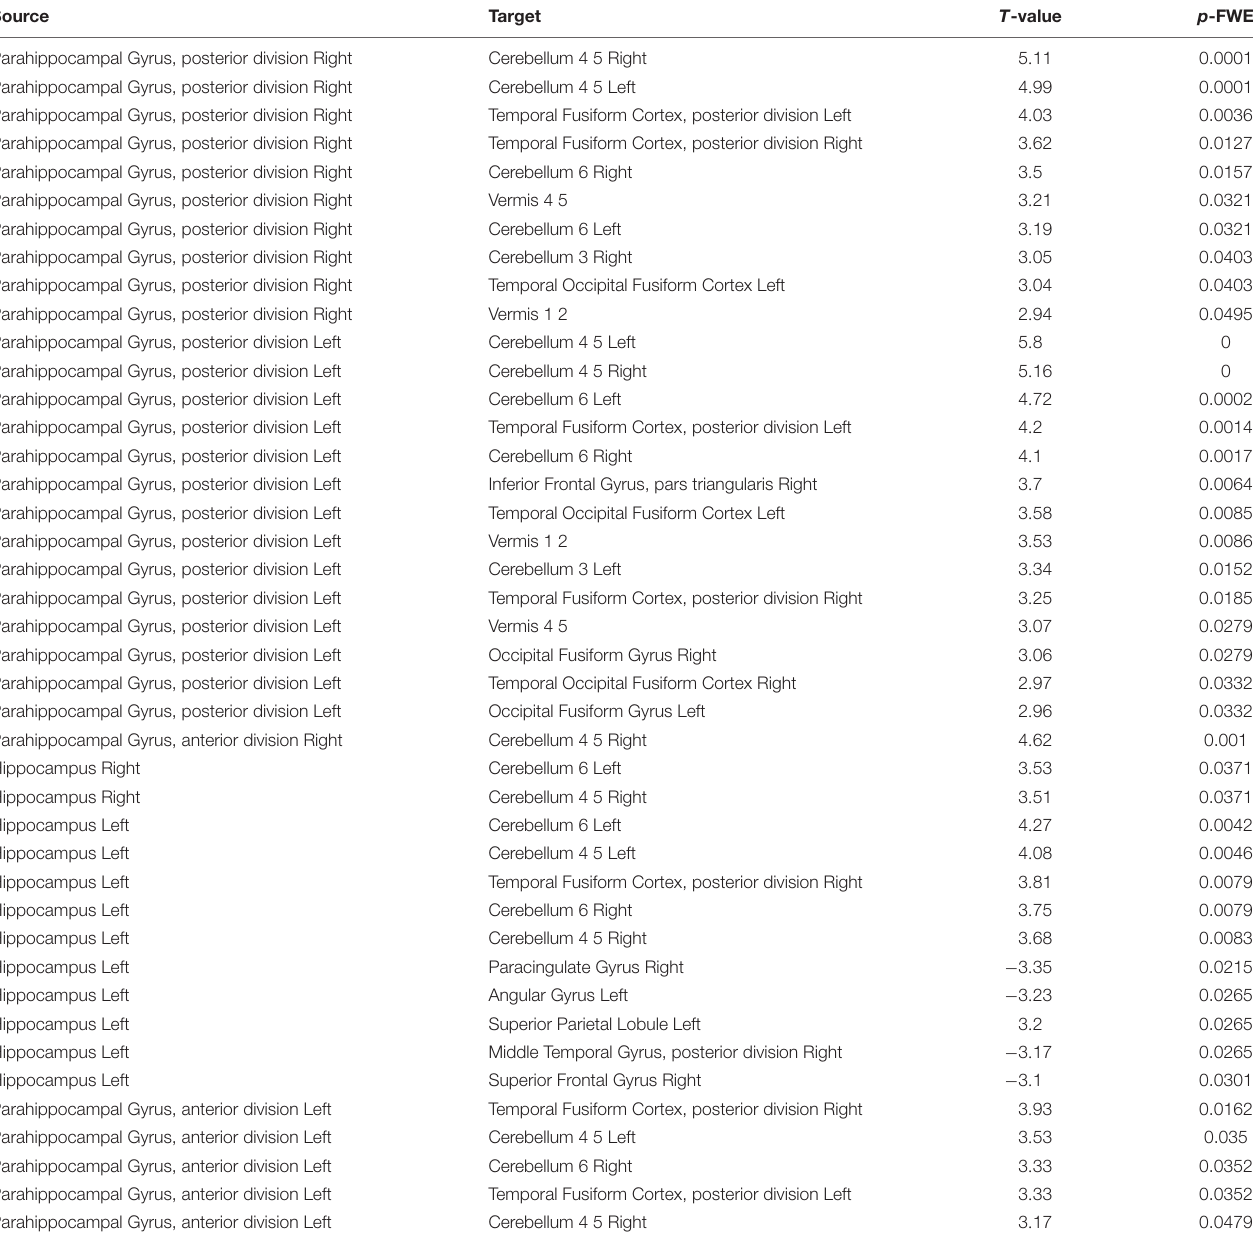
TABLE 3 | Significantly altered connections comparing young adult non-users and aged non-users in an ROI to ROI analysis, using bilateral anterior parahippocampus, bilateral posterior parahippcampus, and bilateral hippocampus as seed regions. Source Target T